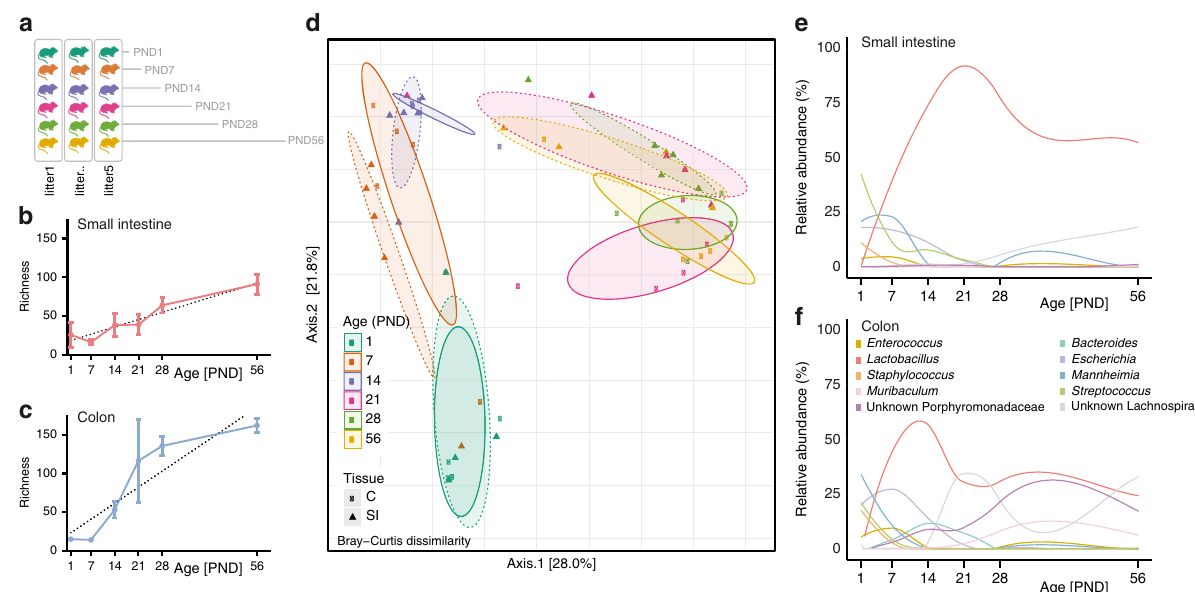
Fig. 1 Postnatal dynamics of the intestinal microbiota composition. a Image illustrating the study outline; one mouse from each one litter was analyzed for each individual time point (PND). b and c Richness (observed species) of the small intestinal ( b ) and colonic ( c ) microbiota exhibiting a gradual increase with age ( n = 5 per PND for all subsequent analyses, mean and SD, p < 0.0001, linear regression R 2 = 0.7702 and p < 0.0001, linear regression R 2 = 0.7281, respectively). d Principal Coordinate Analysis (PCoA) based on Bray-Curtis dissimilarity indicating a gradual shift in microbial community structure along PC2 during the neonatal period PND1-PND14 and distinct structures for the small intestine and colon along PC2 at PND21-56 ( p < 0.001, two-sided, Permanova for age and p < 0.01 two-sided, Permanova for tissue); Squares and solid line: colon (C); triangles and dashed line: small intestine (SI). e , f Relative abundances of the 10 most abundant genera listed in f between PND1-56 for the small intestine ( e ) and colon ( f ). Source data are provided as a Source Data fi